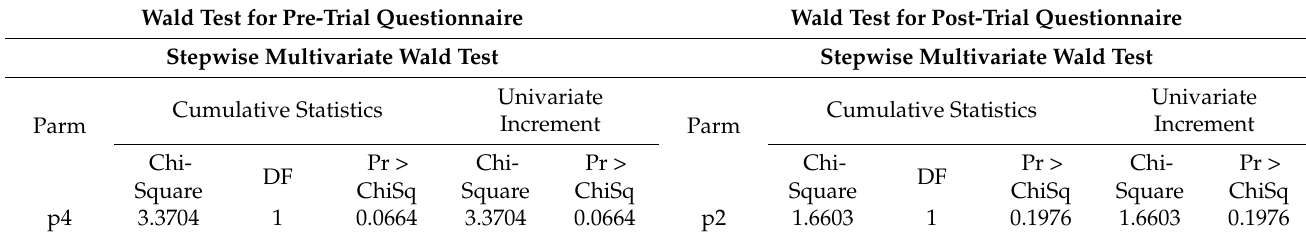
Table 10. Wald test